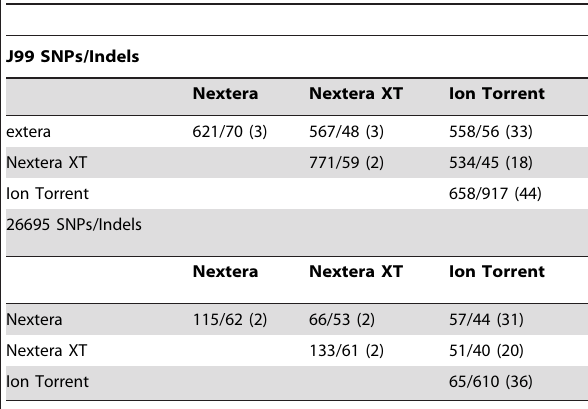
Table 3. Single nucleotide polymorphisms and indels that are common to each technology.